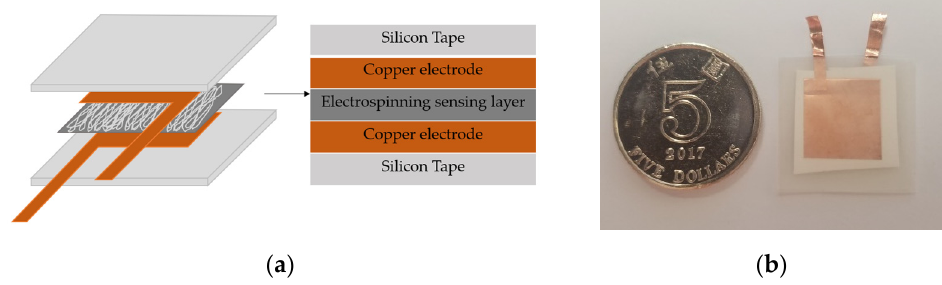
Figure 2. ( a ) Diagram and ( b ) image of the prototype sensor compared with a